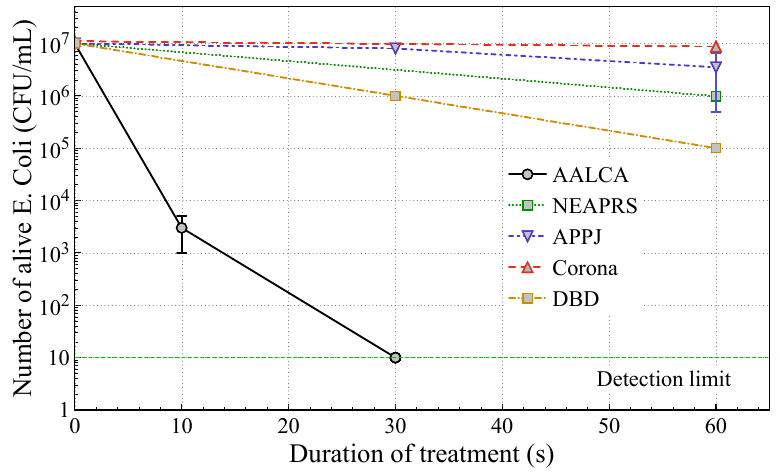
Figure 8. Number of surviving E. coli after treatment by AALCA, NEAPRS, NEAPPJ [43], dielectric barrier discharges (DBD) [49] or corona [50], discharges for various time of irradiation.